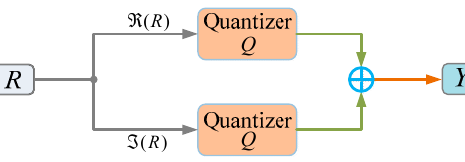
Figure 3. Low-resolution quantization mode.